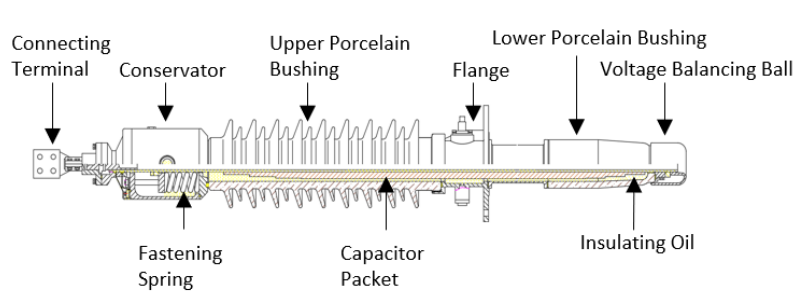
Figure 7. Structure of 72.5 kV bushing.